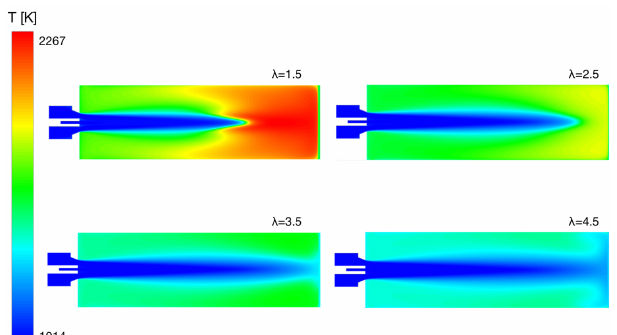
Figure 16. Temperature distribution (K) inside the combustion chamber, for different values of the air-to-fuel ratio. Air inlet temperature 730 ◦ C. EDC model, GRI 2.11 kinetic